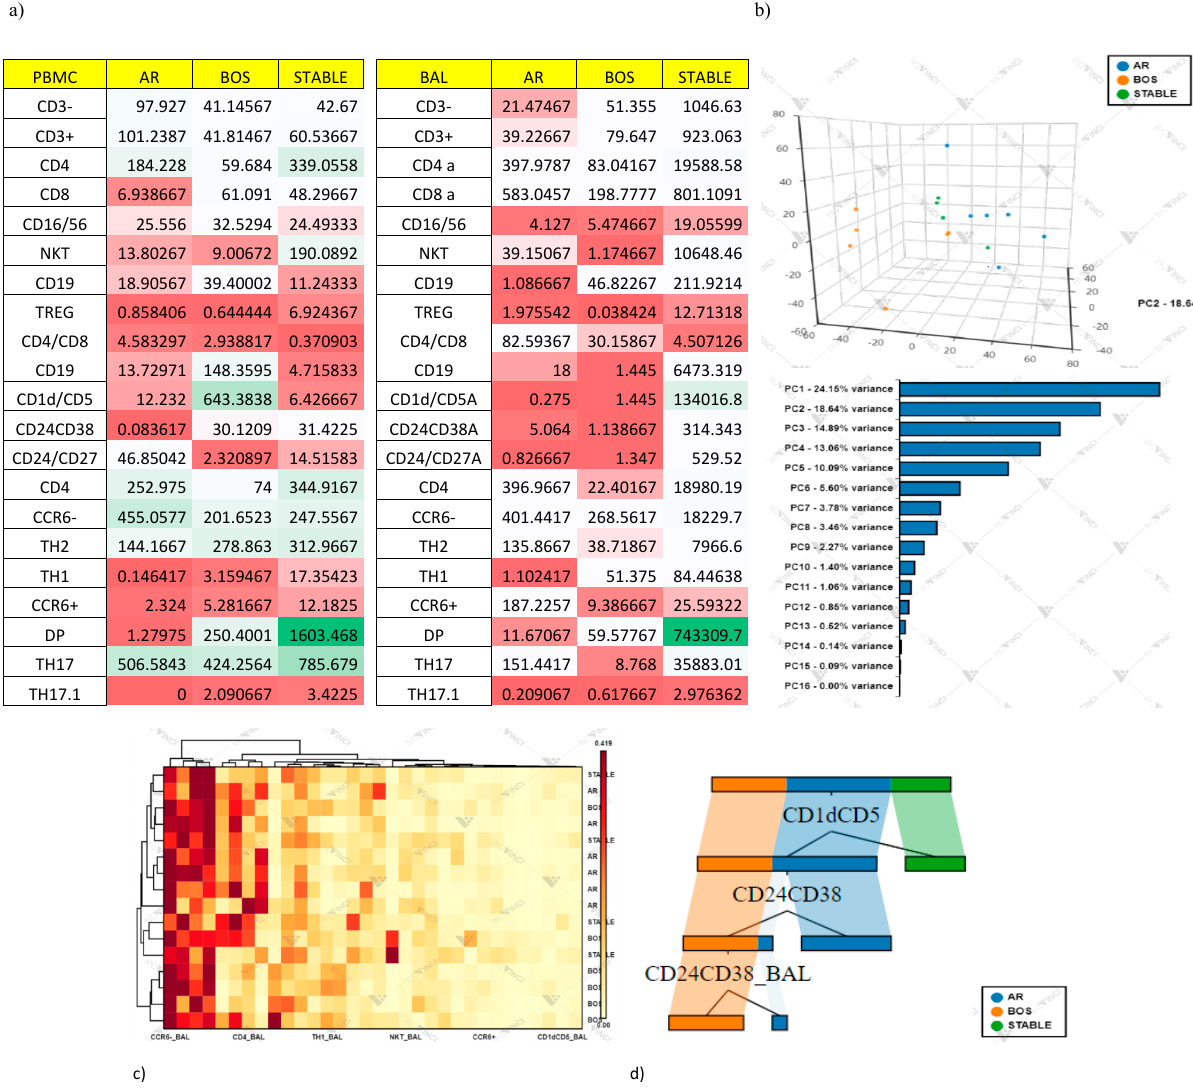
Figure 9. ( a ) Interindividual variance (CV) for cell populations was calculated for each three conditions on PBMC and BAL samples. ( b ) Principal Component Analysis (PCA) of cells. ( c ) The heat map analysis. ( d ) The cellular subsets of patients were employed to create a decision tree model for the detection of best clustering variables. PCA plots showing effect for each sample on cellular variation in these three condi- tions: AR, ( n = 6) BOS ( n = 6) and Stable ( n = 4). The first PC and second PC resolved 24.15% and 18.64% of the total variance, respectively (Figure 9b). The heat map is based on hierarchical clustering applied for row and columns and reported as Euclidean distance. The color of the heat varies from white indicating relative under-representation to red indicating relative over-representation. Clusters are sorted according to adjusted p